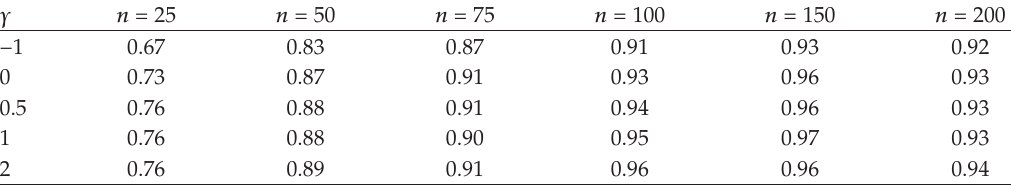
Table 7: Empirical coverage probabilities for the exponential distribution, B (cid:6)